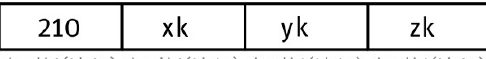
Figure 6. Measurement data frame.